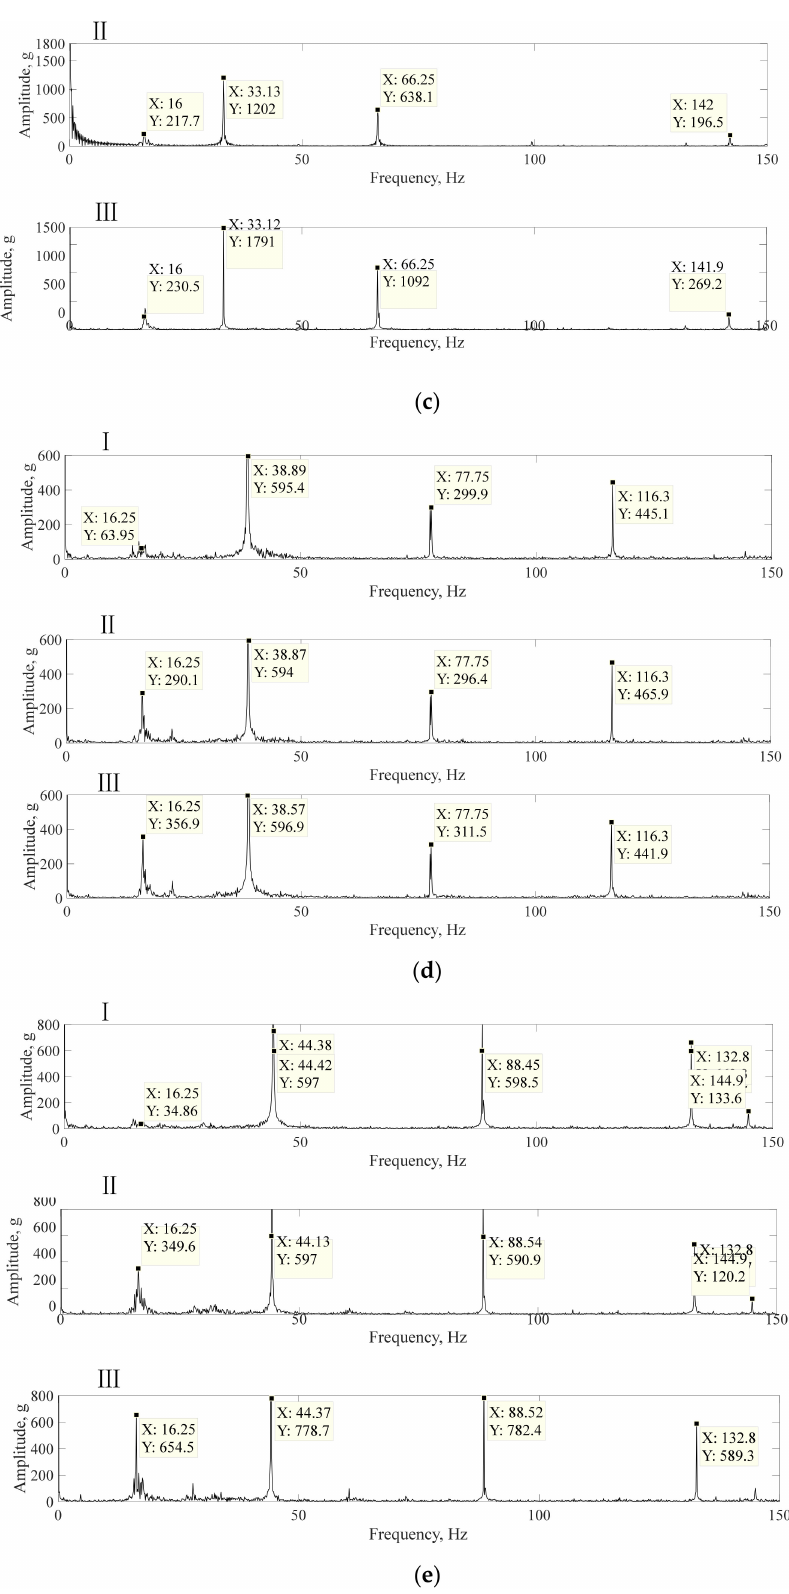
Figure 5. Frequency domain distribution with blockage degree of I 0%, II 50% and III 100% under the throughput ( a ) 8 m 3 / h ( b ) 10 m 3 / h ( c ) 12 m 3 / h, ( d ) 14 m 3 / h and ( e ) 16 m 3 /